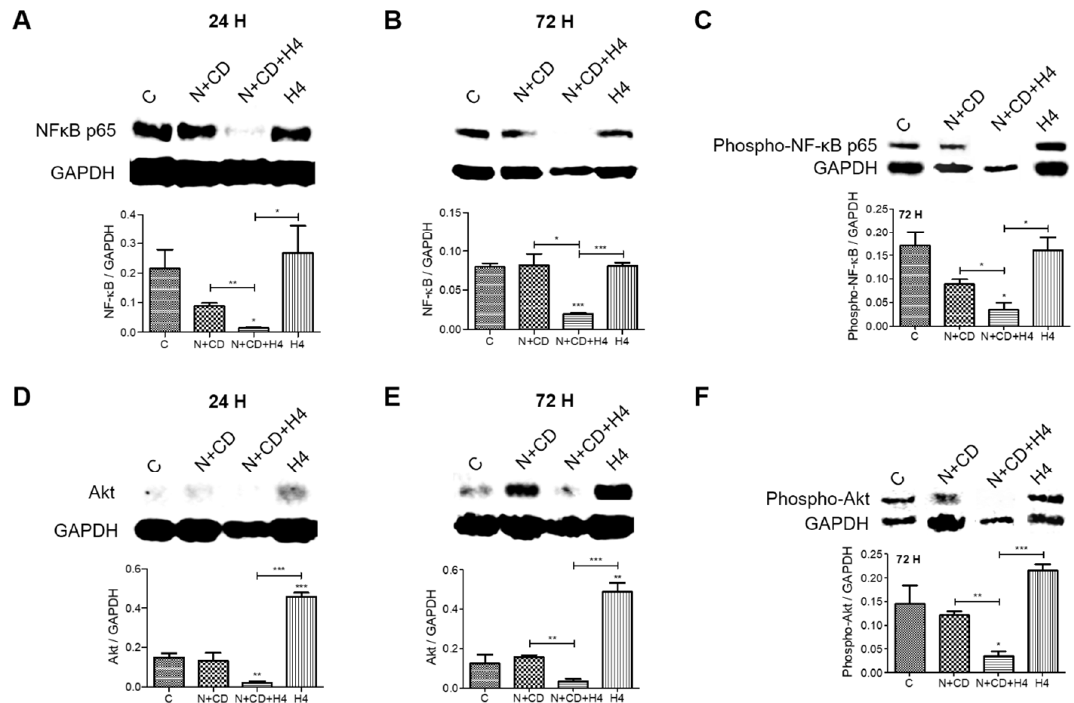
Figure 6. Effect of FUS, alone and in combination with CDDO-me and/or nelfinavir, on both total and activated NF- κ B and Akt protein levels in DU145 cells. The effect of combined treatment with nelfinavir and CDDO-me (CD), alone or in combination with FUS (N + CD + H4), on both total and activated (phosphorylated) NF- κ B p65 ( A – C ) and Akt ( D – F ) protein levels is shown. Representative immunoblot images are in the top panel, along with the loading control (GAPDH). Bar graphs in each of the bottom panels of A–F show normalized densitometric values. Data are representative of three independent experiments ( n = 3). Significant changes from untreated controls or individual treatment groups are shown as p -values (* p < 0.05; ** p < 0.01; and *** p < 0.001). Unlike the recurrence of NF- κ B and Akt levels in DU145 cells exposed to FUS alone (cf. Supplemental Figure S1), our three-treatment combination (N+CD+H4) abrogated the reactivation of these two crucial transcription factors.